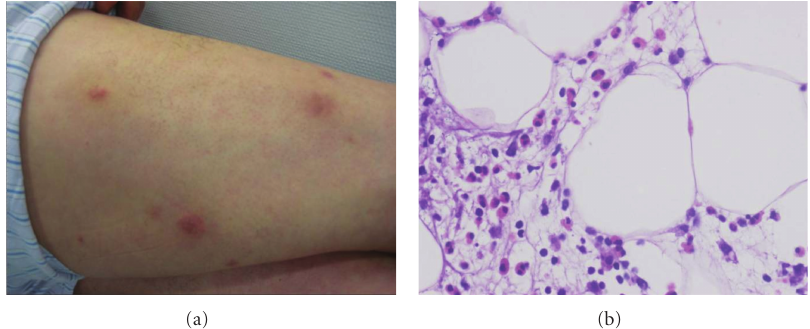
Figure 1: (a) Inflammatory nodules on thighs. (b) Panniculitis with eosinophils infiltration.